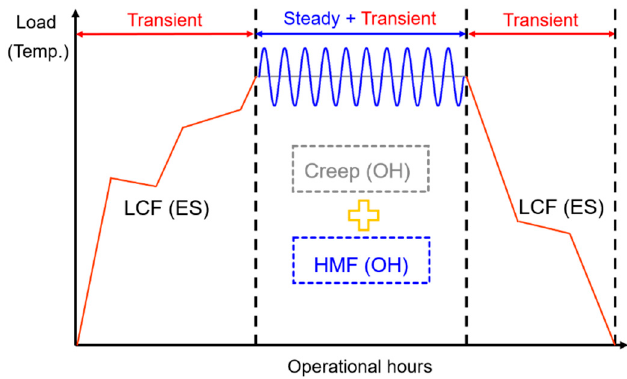
Figure 7. The proposed approach for predicting the remaining useful lifetime (RUL) and coating failure of blades and vanes in a gas turbine.